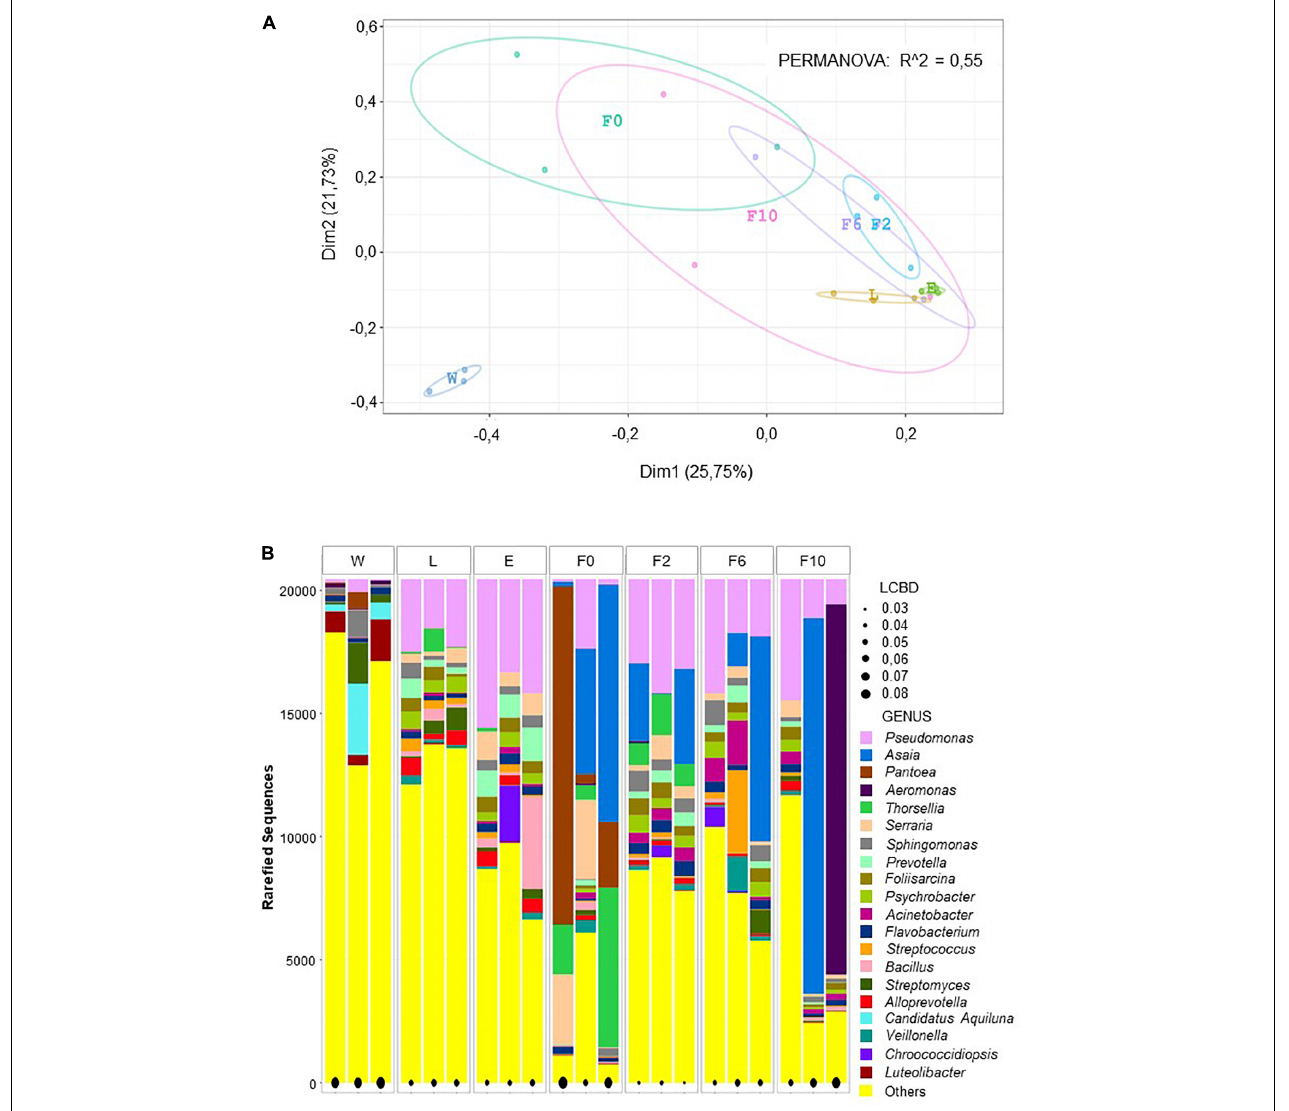
FIGURE 2 | Beta diversity analyses at genus level depicted microbial community variation. PCoA plot showing bacterial community clustering and segregation according to origin. Color points represent the microbiota of a pool of 20 individuals and color ellipses represent confidence intervals per sample type (A) . Local contribution to beta diversity analysis (LCBD) showing the uniqueness of bacterial community composition per pool per sample type. The measure of the input is given the size of the black dot (e.g., the larger the dot, the more unique the microbial community) (B) . Sample types: W, breeding water; L, larvae; E, newly emerged females; F0, wild-caught females; F2, F6, and F10, laboratory-reared females from the second, sixth, and 10th generations,